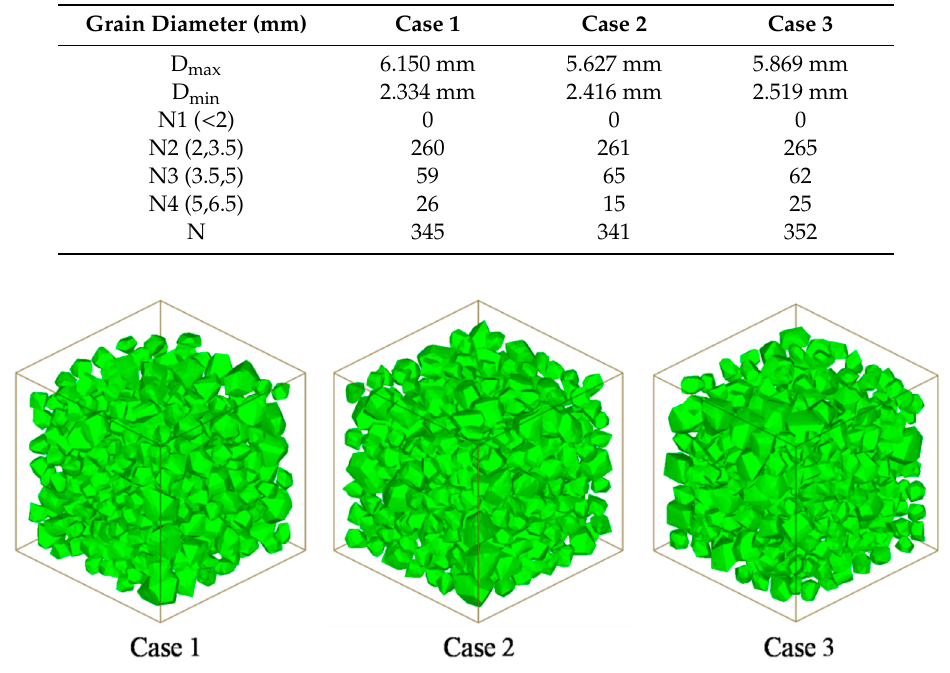
Materials 2019 , 12 , x FOR PEER REVIEW Figure 16. 3D mesoscale model of three di ff erent size distributions. Figure 16. 3D mesoscale model of three different size distributions.